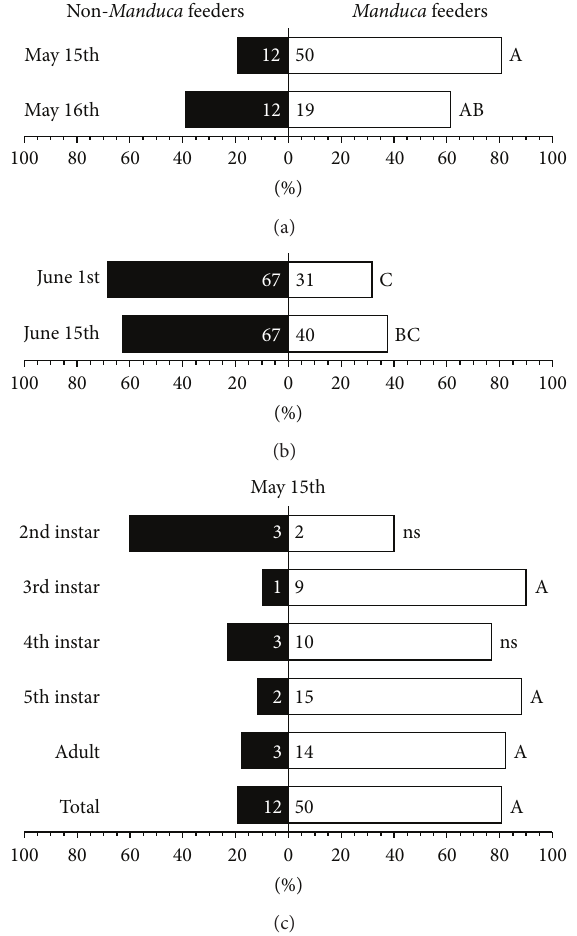
Figure 6: G. pallens collected from a single wild N. attenuata population vary in their tendency to eat M. sexta eggs, but different stages in a single collection do not. Graphs show percentages of G.